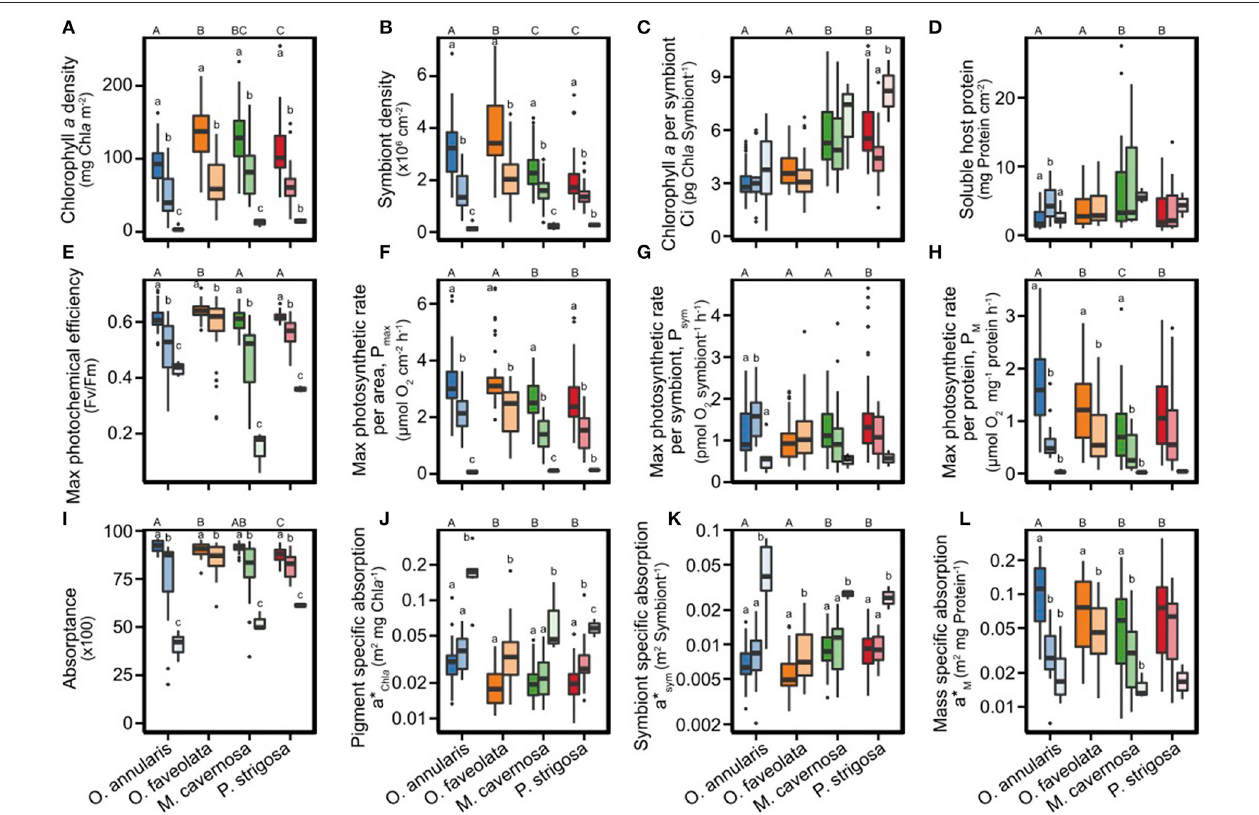
FIGURE 3 | Box plots of the variation of structural (A–D) , photosynthetic (E–H) , and optical (I–L) descriptors of the holobiont phenotype of Orbicella annularis (blue), Orbicella faveolata (orange), Montastraea cavernosa (green), and Pseudodiploria strigosa (red). Different shading describes the unstressed (dark), heat-stressed (light), and bleached phenotypes (lighter). Boxes encompass the 25 and 75% quartiles. The central line corresponds to the median, and bars extend to the 95 and 5% of the confidence limits. Uppercase letters indicate significant differences among species, while lowercase letters denote differences among coral phenotypes (ANOVA tests were performed across species using two-way ANOVA). The lack of lowercase letters indicate that changes were not